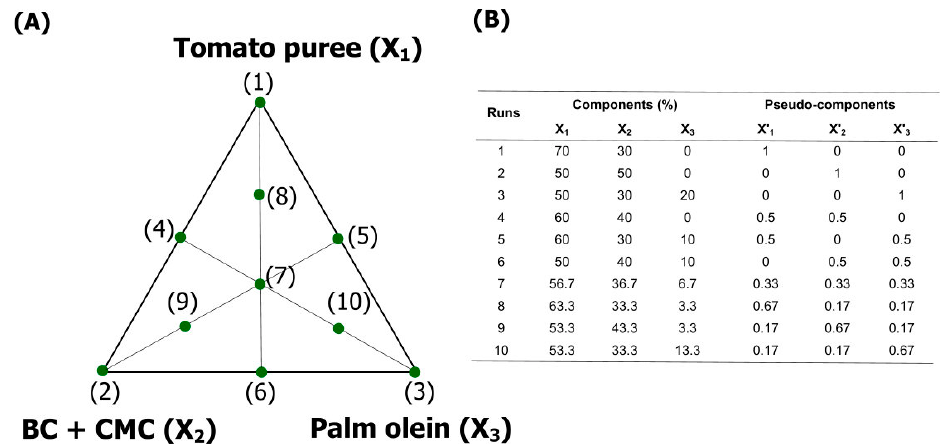
Figure 1. Simplex centroid design. ( A ) Graphical representation of the experimental runs (film formulations). ( B ) Conditions (as components and pseudo-components) of each run.